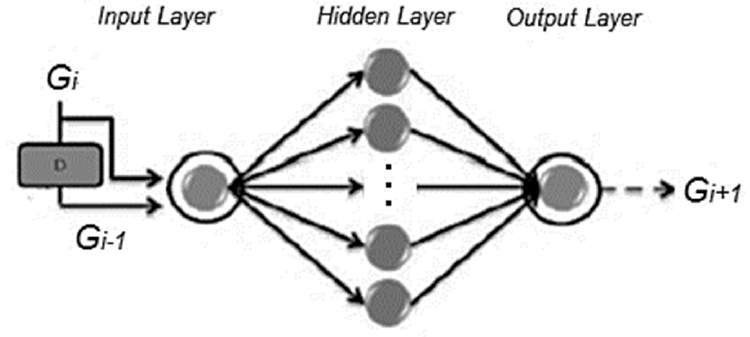
Figure 2. General structure for the TDNN [36].